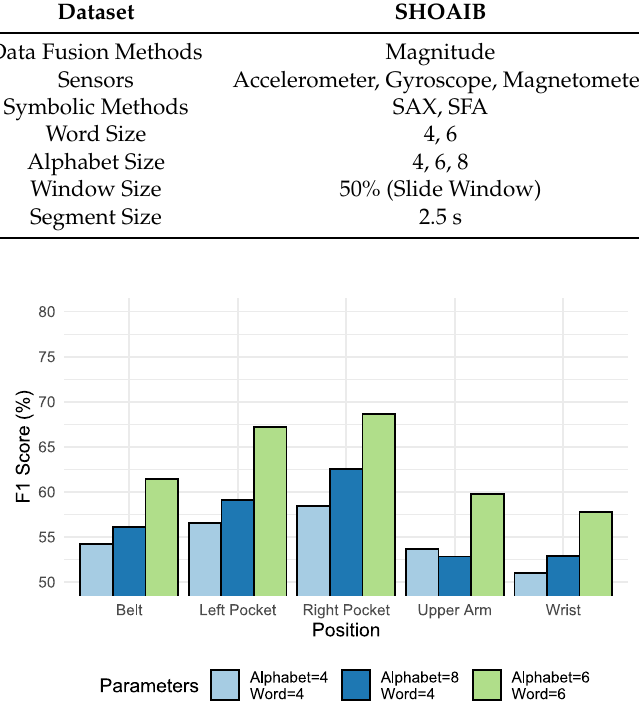
Figure 10. Average performance of symbolic algorithms with variation in parameters ω and α for each body position of SHOAIB dataset.